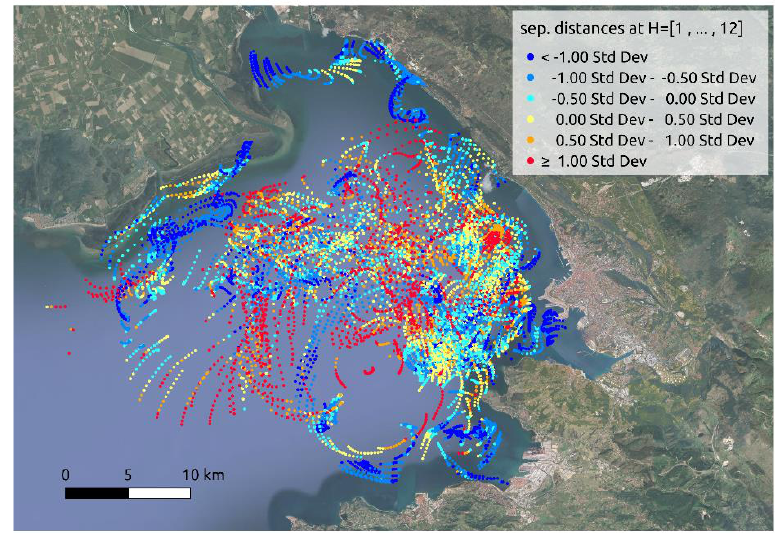
Figure 12. GoT map highlighting the correlation between the distance from the coast and the value of the separation distance at the drifter positions (colored dots). Std Dev in the legend stands for standard deviation.